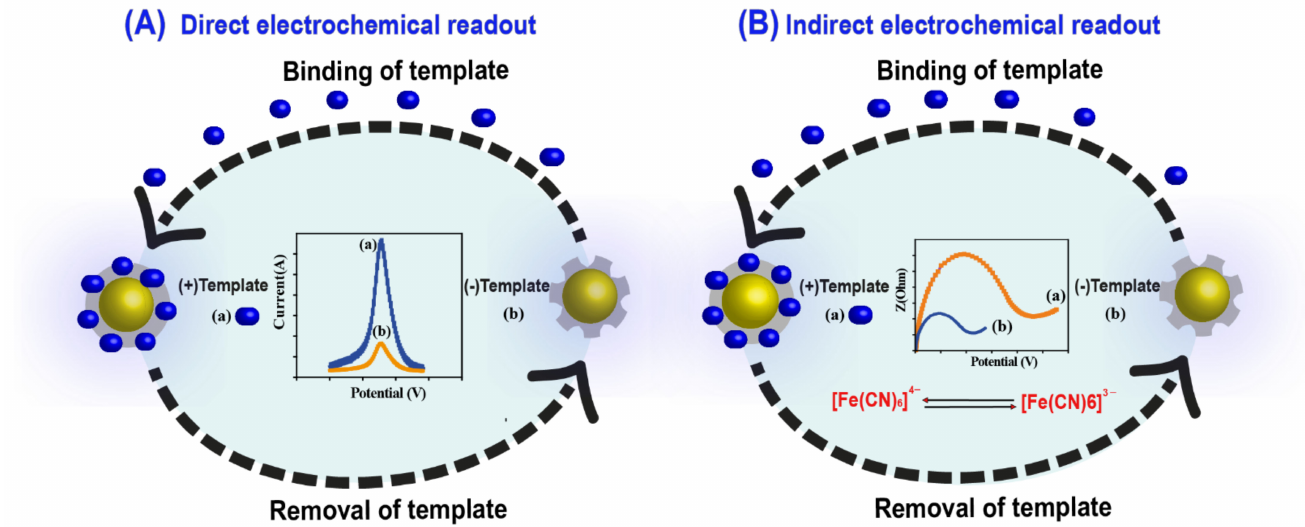
Figure 4. Graphical sketch of generic ( A ) direct and ( B ) indirect electrochemical measurements combined with